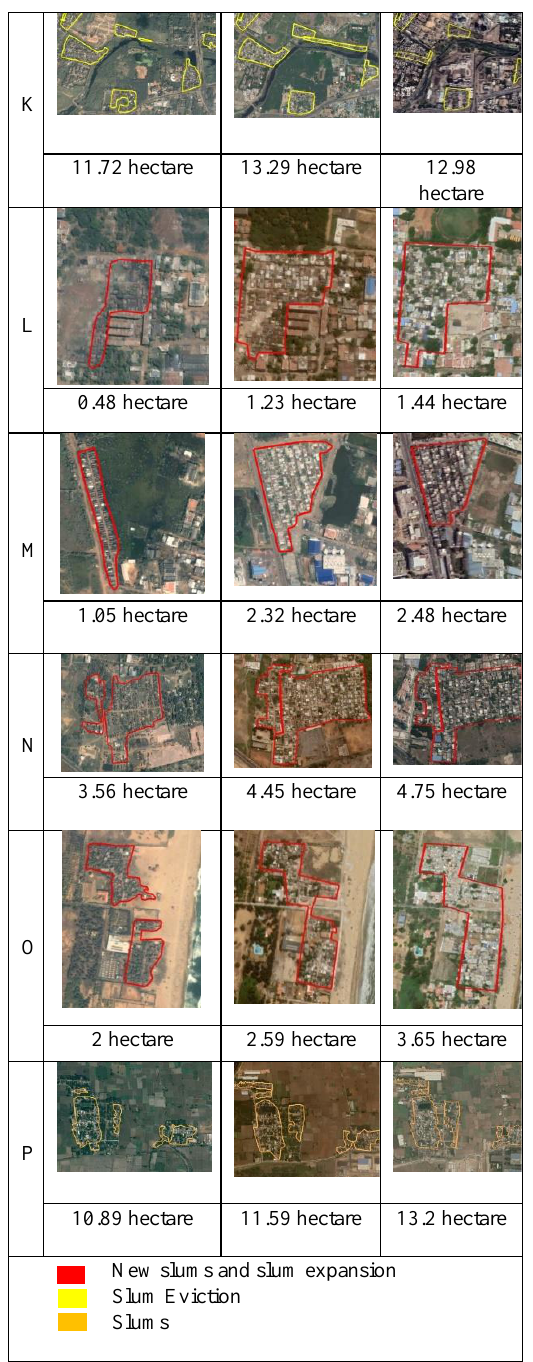
Table 5. Samples show the Changes in slum